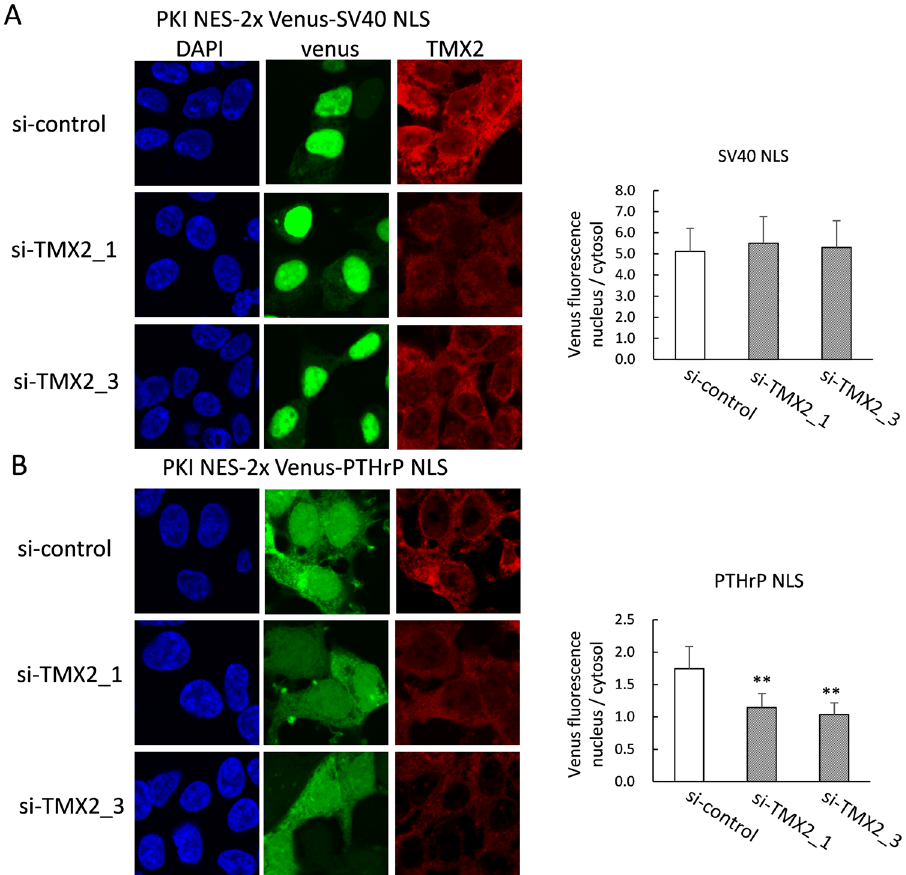
Figure 5. TMX2 knockdown decreased importin- β -dependent nuclear transport of protein. The expression plasmid for NES-2xVenus-SV40 NLS ( A ) or NES-2xVenus-PTHrP NLS ( B ) was co-transfected with control si-RNA or si-TMX2 into HEK293 cells. After 48 h, cells were fixed and incubated with anti-TMX2 antibody, followed by secondary antibody labeling with Dylight 647. The nucleus/cytosol ratio of Venus fluorescence was measured in about 30 cells. Values are the means ± S.D. ** p < 0.01 compared with the